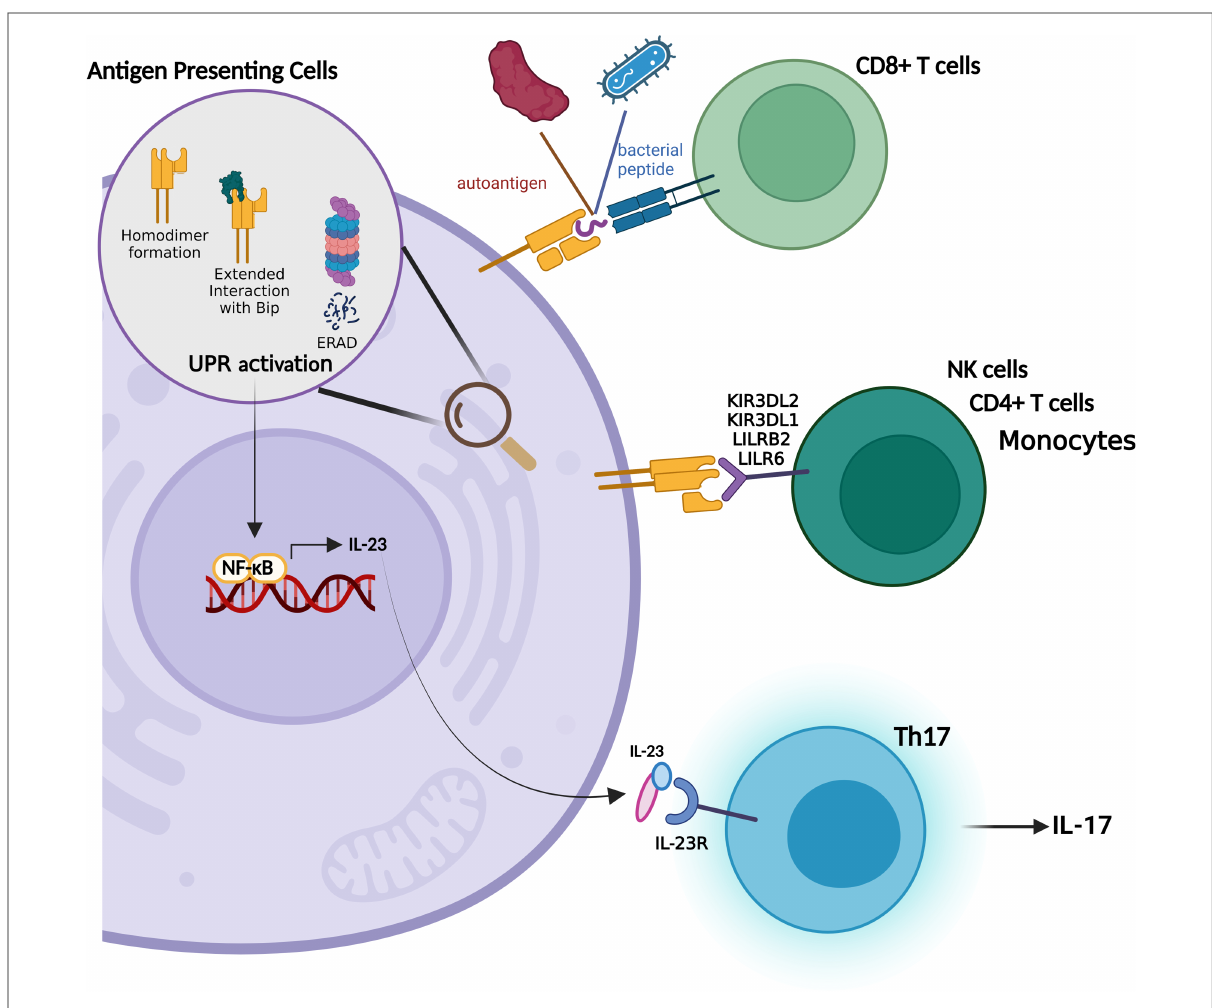
FIGURE 3 HLA-B27 related theories in SpA